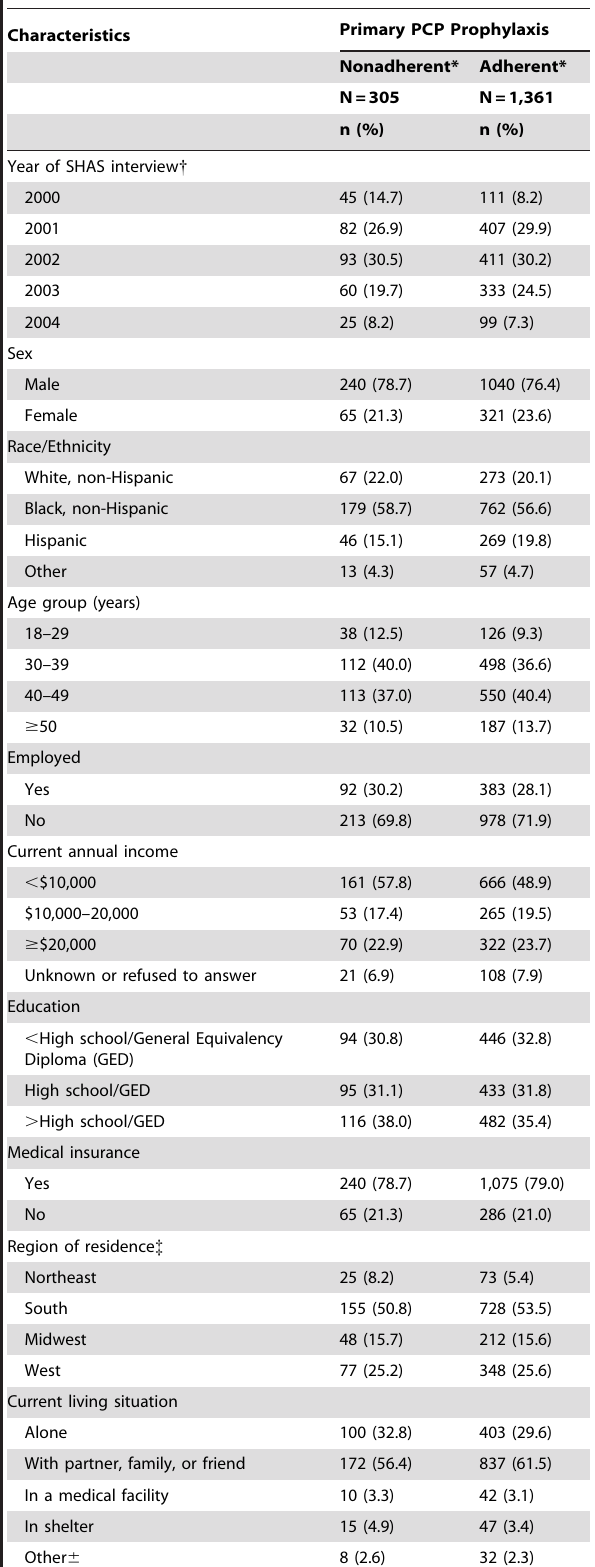
Table 1. Characteristics of 1,666 persons with HIV infection prescribed primary prophylaxis against Pneumocystis jirovecii pneumonia (PCP), by nonadherence to prophylaxis – Supplement to HIV/AIDS Surveillance (SHAS) project, 2000–2004. Characteristics